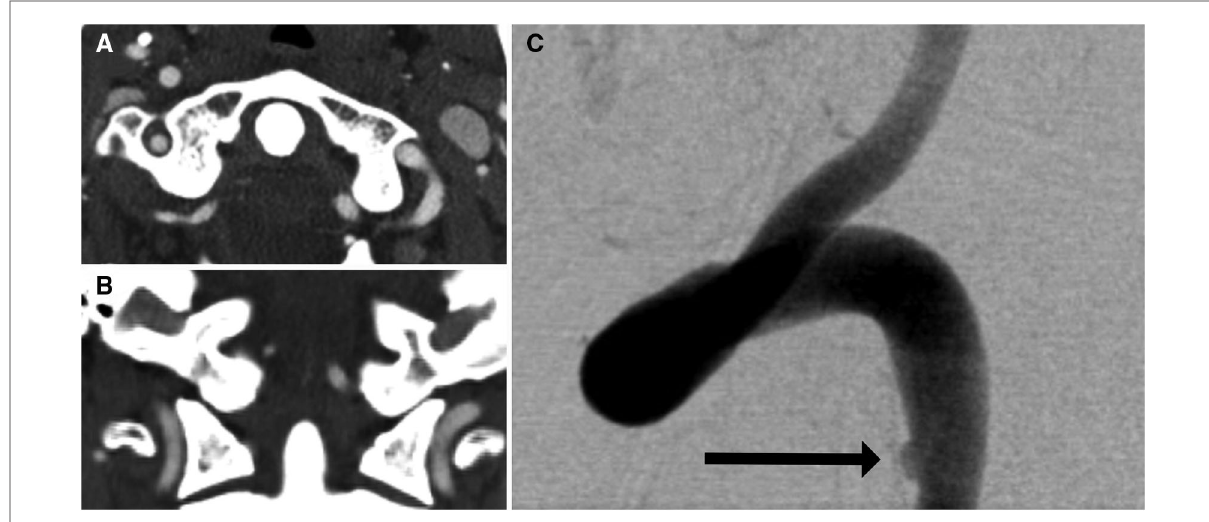
FIGURE 2 Imaging of a 35-year-old man who presented after a motor vehicle crash. Initial axial ( A ) and coronal ( B ) CTA were negative for vertebral artery dissection. Because of a high level of suspicion for vertebral artery injury, DSA ( C ) was performed. DSA showed subtle intimal injury involving the left vertebral artery (arrow).